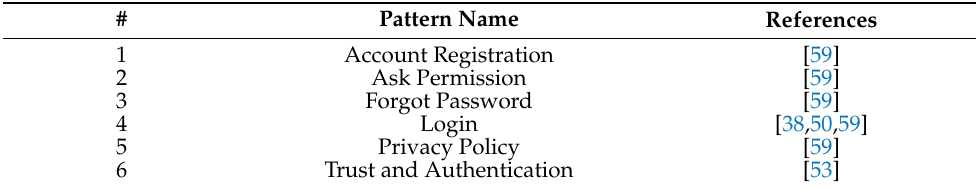
Table 9. Authentication and Privacy